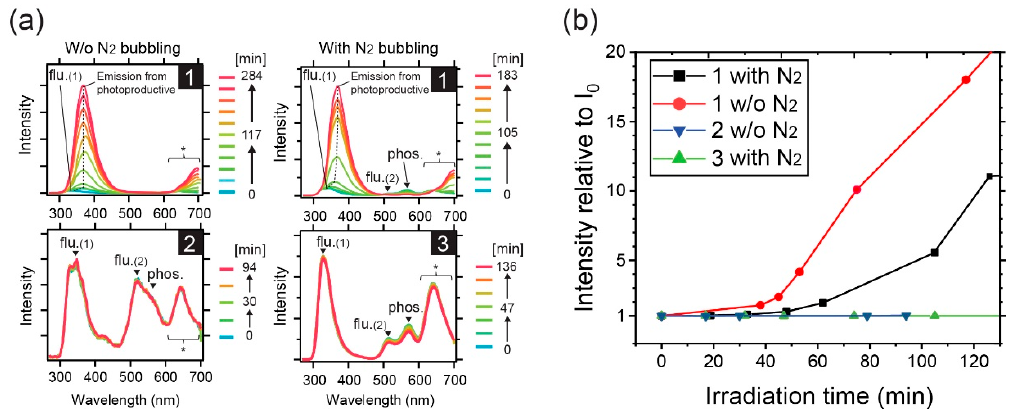
Figure 3. Photostability of 1 − 3 in toluene solutions. ( a ) Irradiation time dependence of PL spectra of 1 − 3 derivatives. The irradiations were conducted continuously to 1 and 2 solutions prepared w/o N 2 bubbling, and 1 and 3 solutions with N 2 bubbling. Asterisk (*) is the region of second order diffracted light of flu.(1) or photo-productive emission band. ( b ) Time evolution of the intensity ratio at the peak at around the flu.(1) bands (dashed line in Figure 3a) started from the initial peak intensity ( I 0 ).